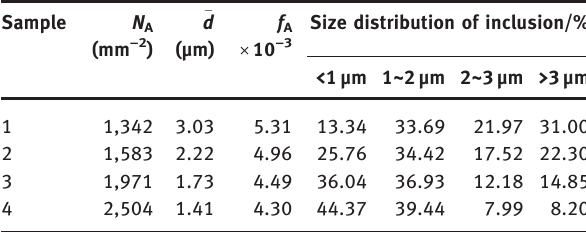
Table 2: Characteristics of particles in four steel samples.